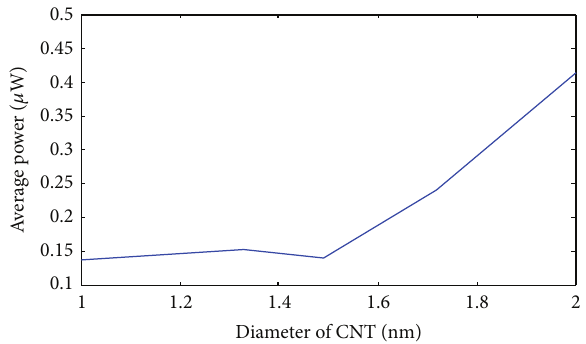
Figure 5: Effect of diameter variations on average power consump- tion for pure technology